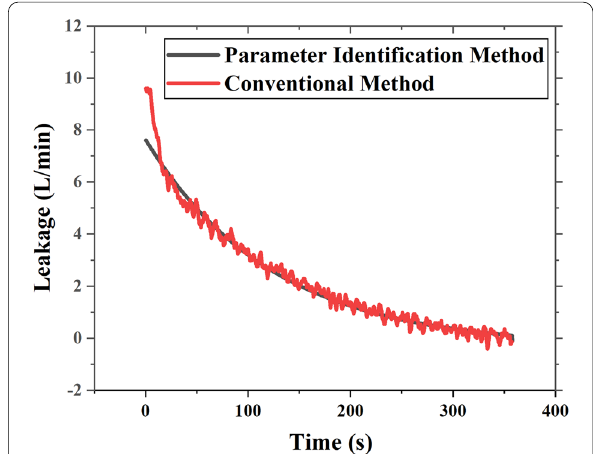
Figure 10 Comparison of leakage calculation between conventional method and substitute equation